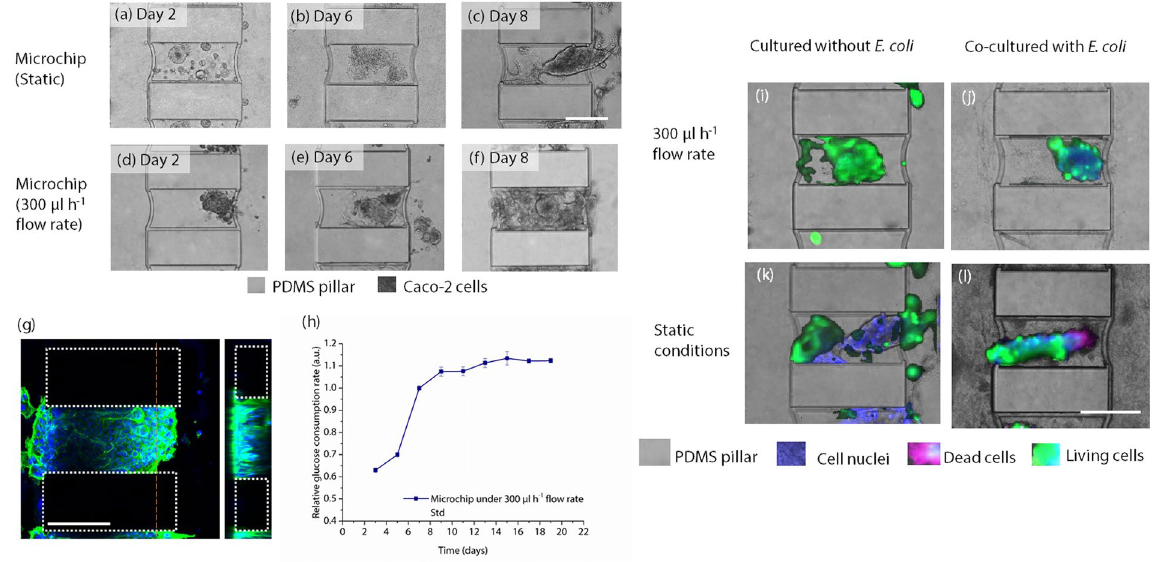
Figure 2. Left: Top-view phase contrast images of Caco-2 cells in the microchip in different days of cell culture. The results are shown for the microchips operated ( a–c ) under static conditions and ( d–f ) under 300 µ l h − 1 flow rate. ( g ) Confocal microscopy image of the Caco-2 cells grown under 300 µ l h − 1 flow rate on day 8. Dashed lines denote pillar boundaries, red dashed line shows location of y-z cross-section (inset right) ( h ) Glucose consumption rate of Caco-2 cells cultured inside the microchip over 21 days. Right: Top-view phase contrast microscopy images of live/dead assay bacteria co-culture operated ( i ) under 300 µ l h − 1 flow rate without E. coli cells, ( j ) under 300 µ l h 1 − 1 flow rate with E. coli cells, ( k ) without fluid flow and without E. coli cells ( l ) without fluid flow with E. coli cells. The nuclei of Caco-2 cells were stained with DAPI (blue). Alive Caco-2 cells are shown in green and dead Caco-2 cells are shown in red colors. In ( j and l ) the dark cloudy appearance in the microchannels and the compartments is caused by E. coli colonies. All scale bars are 250 µ m.